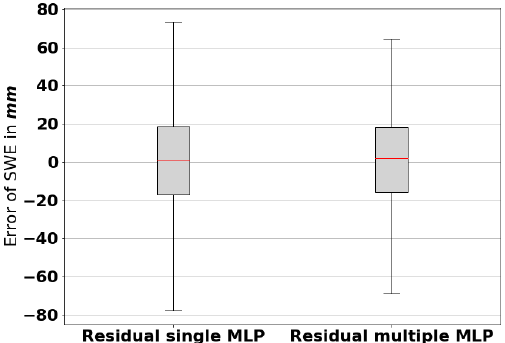
Figure 11. Distribution of the residuals of the simulated ensemble median and the observations. The boundary of the box shows the first and third quartiles; the caps at the end of the whiskers show the 5th and 95th